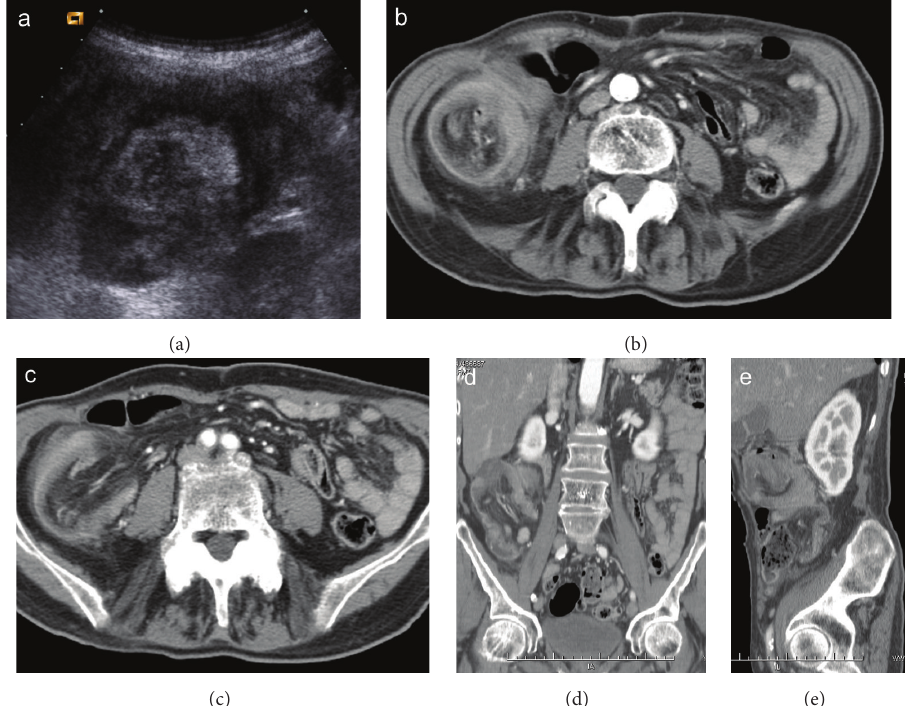
Figure 13: Enterocolic (ileocaecocolonic) intussusception caused by a caecal carcinoma. Ultrasound scan (a) shows a heterogeneous target- like mass located in right flank. CT images on axial scans (b, c) and coronal and oblique reformatting (d, e) demonstrate lead point intussusception with invaginated mesenteric fat, vessels, and lymph nodes.